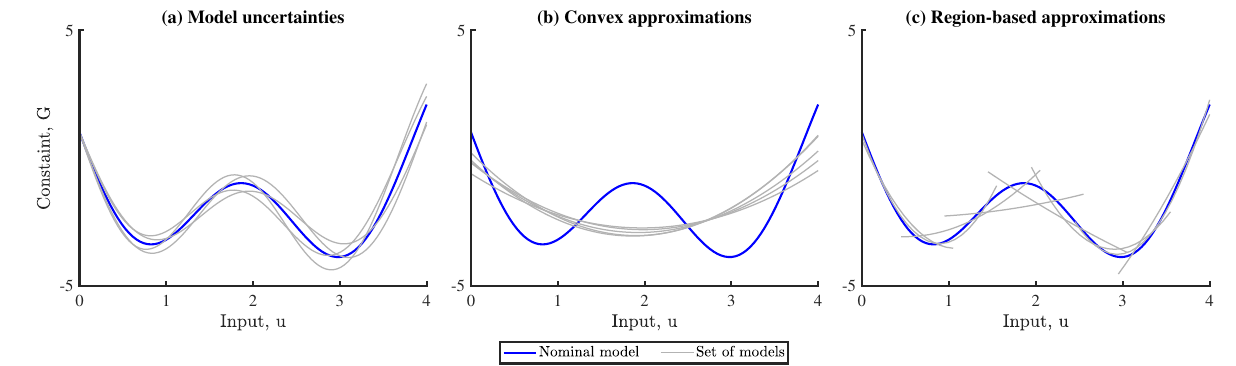
Figure 1. G vs. u for the sets of models for each of the three sets of solution production methods. The blue line represents the nominal model, and the gray line represents the set of